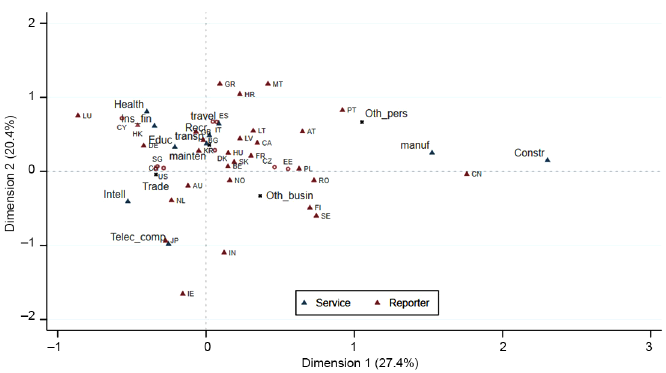
Figure 4. Exports of services by country and service type, 2017 (source: WTO mode of supply dataset, authors’ elaborations